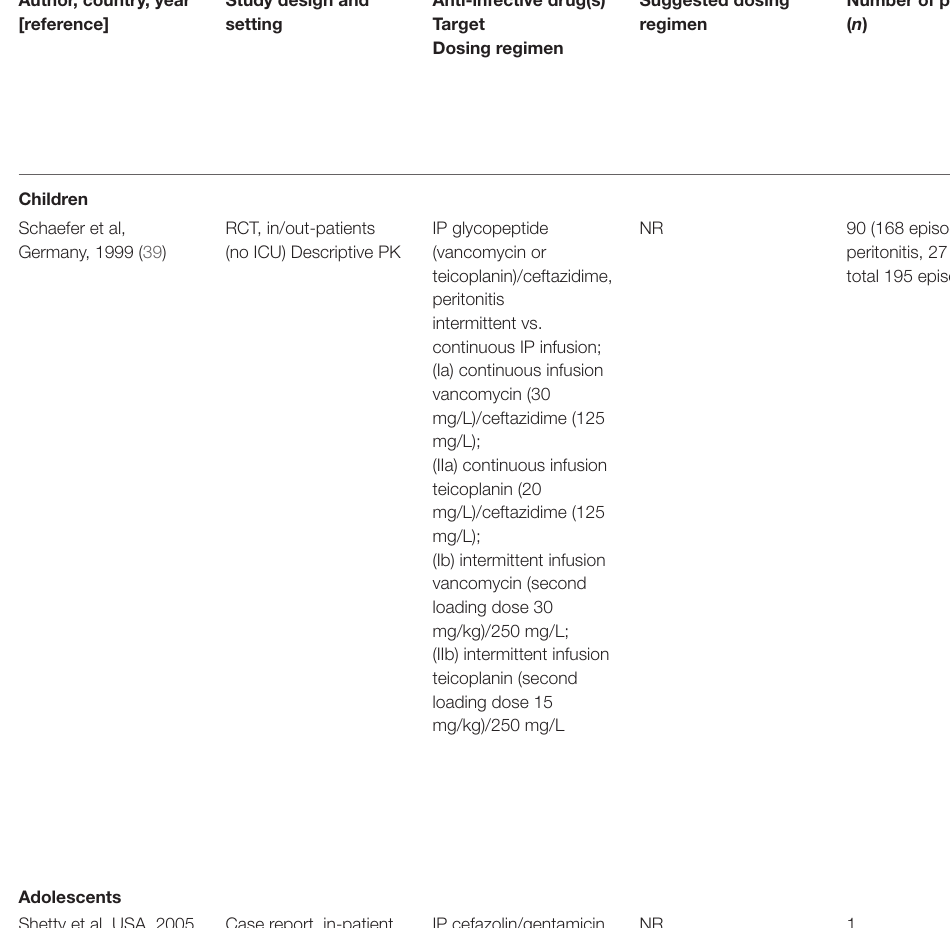
TABLE 8 | Combined antibiotic